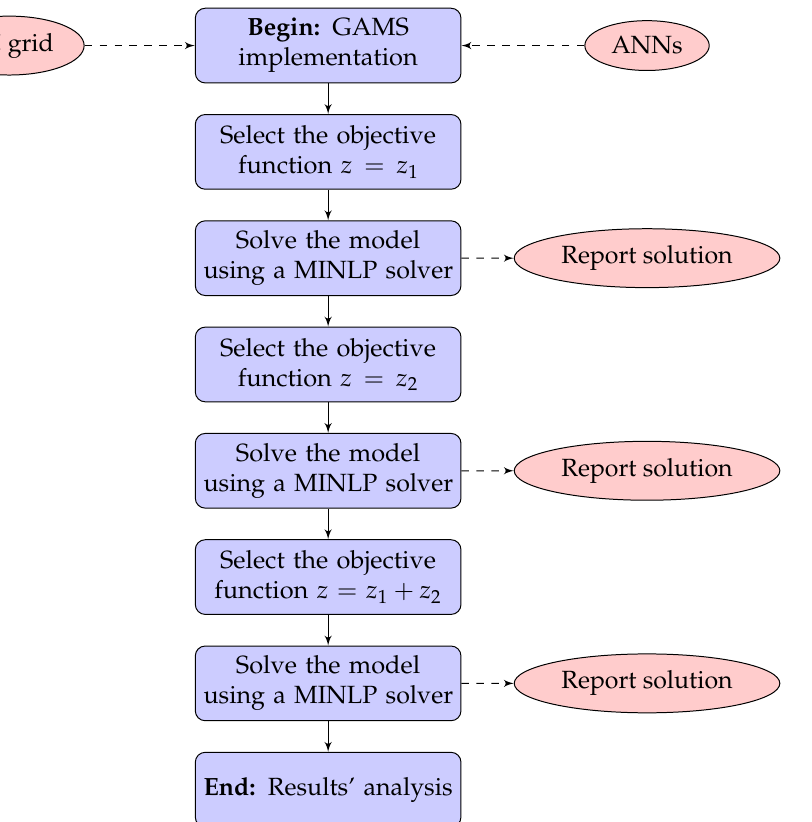
Figure 5. Flow chart of the proposed optimization approach for optimal location-reallocation of batteries in dc grids.